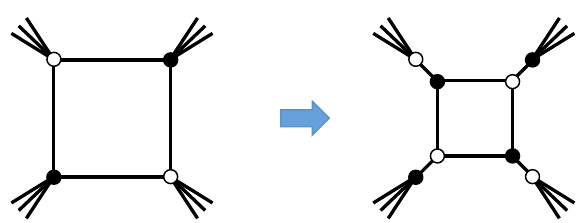
Figure 32. Square move implementing Seiberg duality on a 4-sided face of a BFT.